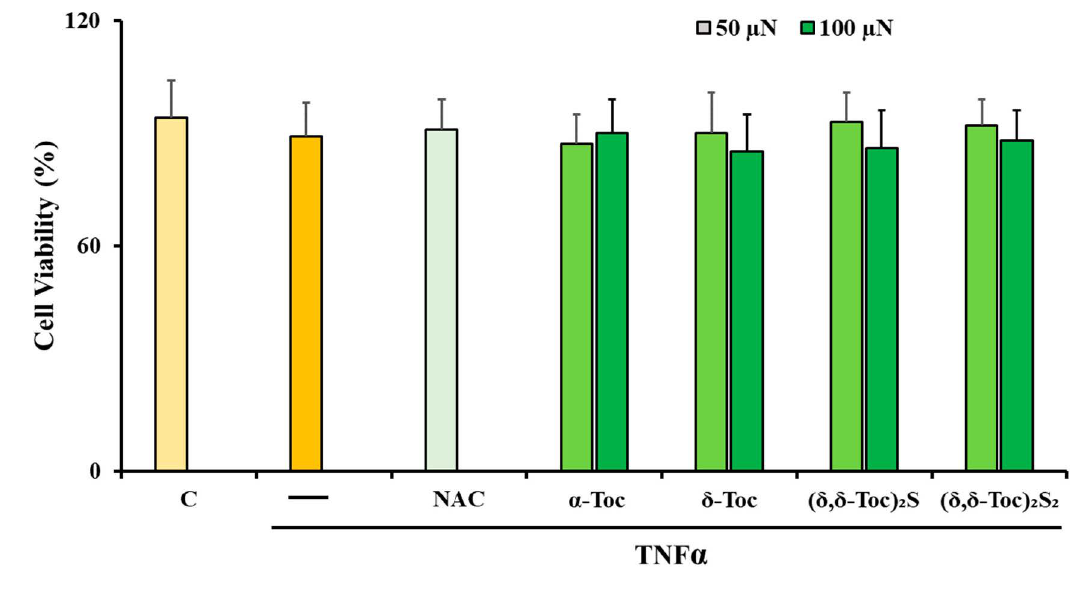
Figure 3. Viability of HT29 pre-treated with natural, α -Toc and δ -Toc , semi-synthetic, ( δ -Toc) 2 S and ( δ -Toc) 2 S 2 , or NAC, and stimulated with TNF α . HT29 cells, pre-treated or not with 50 and 100 µ N of α -Toc , δ -Toc , ( δ -Toc) 2 S , ( δ -Toc) 2 S 2 , or 20 mM NAC, as reported in Materials and Methods, were stimulated or not for 24 h with 10 ng/mL TNF α . Cell viability was performed by Trypan blue dye exclusion test. Percentage of viable cells was calculated considering the ratio between the number of unstained cells and the number of total cells × 100. Values are the mean ± SEM of three experiments repeated in